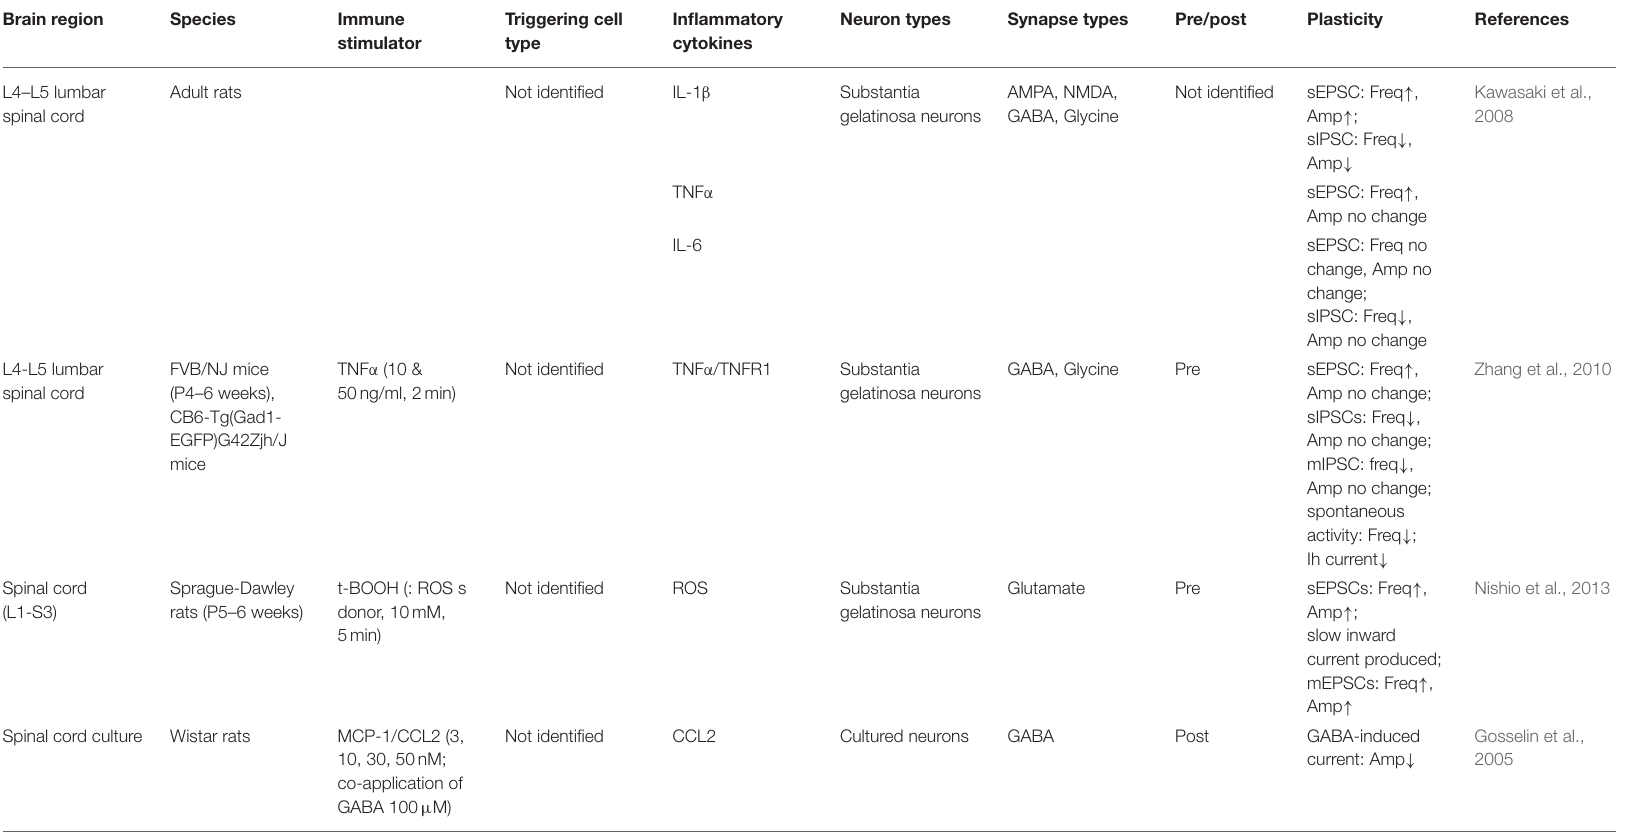
We show a summary table of the immune-triggered modulation of the synaptic efficacy of neurons in different brain regions. We categorized referenced studies by brain region, animal species, stimulants for the immune cell, immune-cell or glia type, inflammatory mediators, neuron types, synapse types, pre-/post- synaptic location, and forms of plasticity (i.e., LTP and LTD). The outcomes are indicated by different signs: increased ( ↑ ), reduced ( ↓ ), and unchanged. Paired-pulse ratio (PPR) is defined as the ratio of response against 2nd stimulation to response against the initial one after a conditioning or reagent administration. Thus, the PPR indicates whether the presynaptic release probability of the synaptic vesicles is changed by the plasticity induction (Blitz et al., 2004). Amp, amplitude; eEPSC, evoked excitatory postsynaptic current; eIPSC, evoked inhibitory postsynaptic current fEPSP, field excitatory postsynaptic potential; Freq, frequency; mEPSC, miniature EPSC; mIPSC, miniature IPSC; mPSC, miniature postsynaptic current; PPR, paired-pulse ratio; PSC, postsynaptic current; PTP, post-tetanic potentiation; sEPSC, spontaneous EPSC; sIPSC, spontaneous IPSC; STP, short-term synaptic plasticity; VDCC, voltage-dependent Ca 2 +